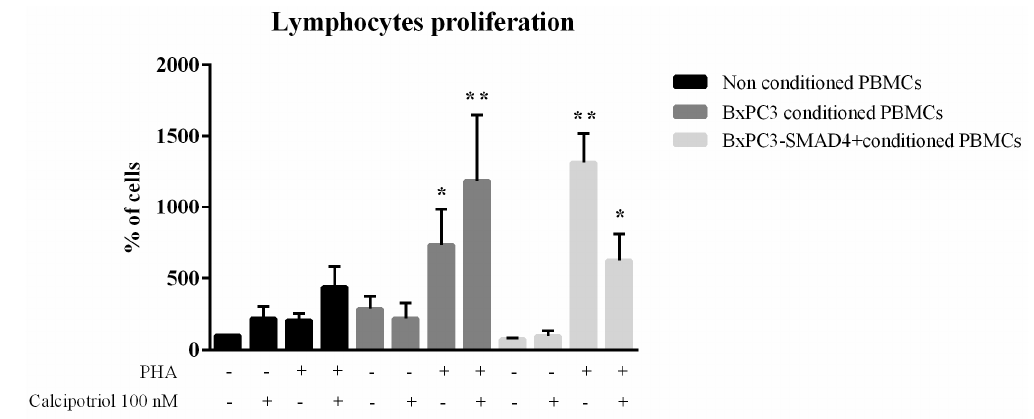
Figure 3. Lymphocytes’ proliferation. Columns show mean values, and bars, standard errors of lymphocyte proliferation after allogenic stimulation with PBMCs that remained non conditioned or were conditioned with BxPC3 or BxPC3- SMAD4+ culture media. Non conditioned and conditioned PBMCs were not or were treated with 100 nMcalcipotriol. For all described conditions, lymphocytes’ proliferation was evaluated in the absence or in the presence of phytohemagglutinin (PHA) (2.5 μ g/mL). Proliferation is expressed as a percentage with respect to values obtained from lymphocytes stimulated with allogenic nonconditioned and not calcipotriol treated PBMCs. Tukey’s multiple comparison test: * = p < 0.05 in comparison with BxPC3 conditioned PHA (-), calcipotriol (-) or (+) and with non conditioned PHA (+) calcipotriol (+); ** = p < 0.001 in comparison with BxPC3-SMAD4+ conditioned PHA (-) calcipotriol (-) or (+) and with nonconditioned PHA (+) calcipotriol (-).